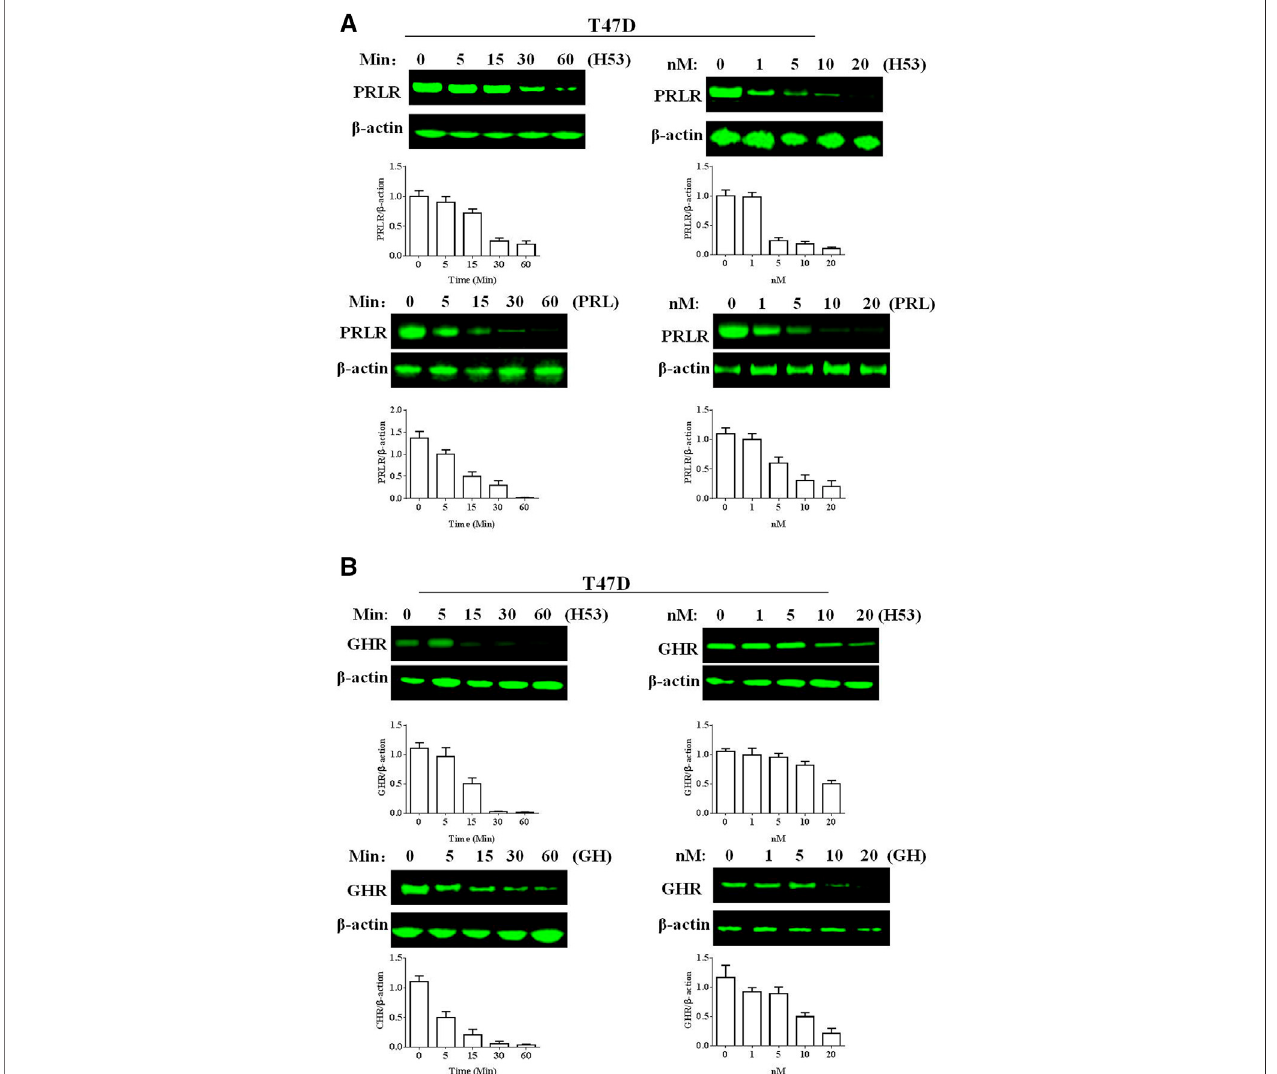
FIGURE 11 | A) H53 down-regulated PRLR/GHR expression in T47D cells. The cells were treated with H53 at the indicated dose and durations. Proteins were isolated from the treated cells for Western blotting. (B) H53 induced GHR down-regulation in T47D cell. Data are presented as the mean ± SD of three independent